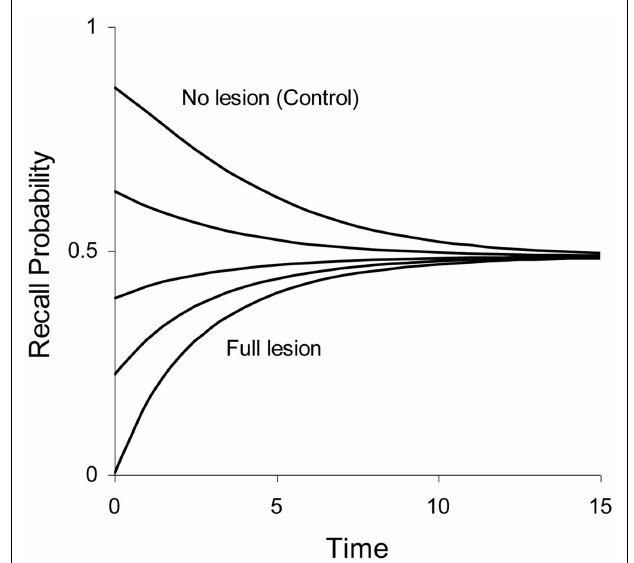
FIGURE 4 | Illustration of partial retrograde amnesia, from a full lesion to no lesion of Process 1 (hippocampus/MTL). Values of the lesion parameter λ were 1.0, 0.875, 0.75, 0.5, and 0.0.The other parameters were µ = 2.0, a = 0.3, µ = 0.1, and a = 0 (simulated data with arbitrary time 1 1 2 2